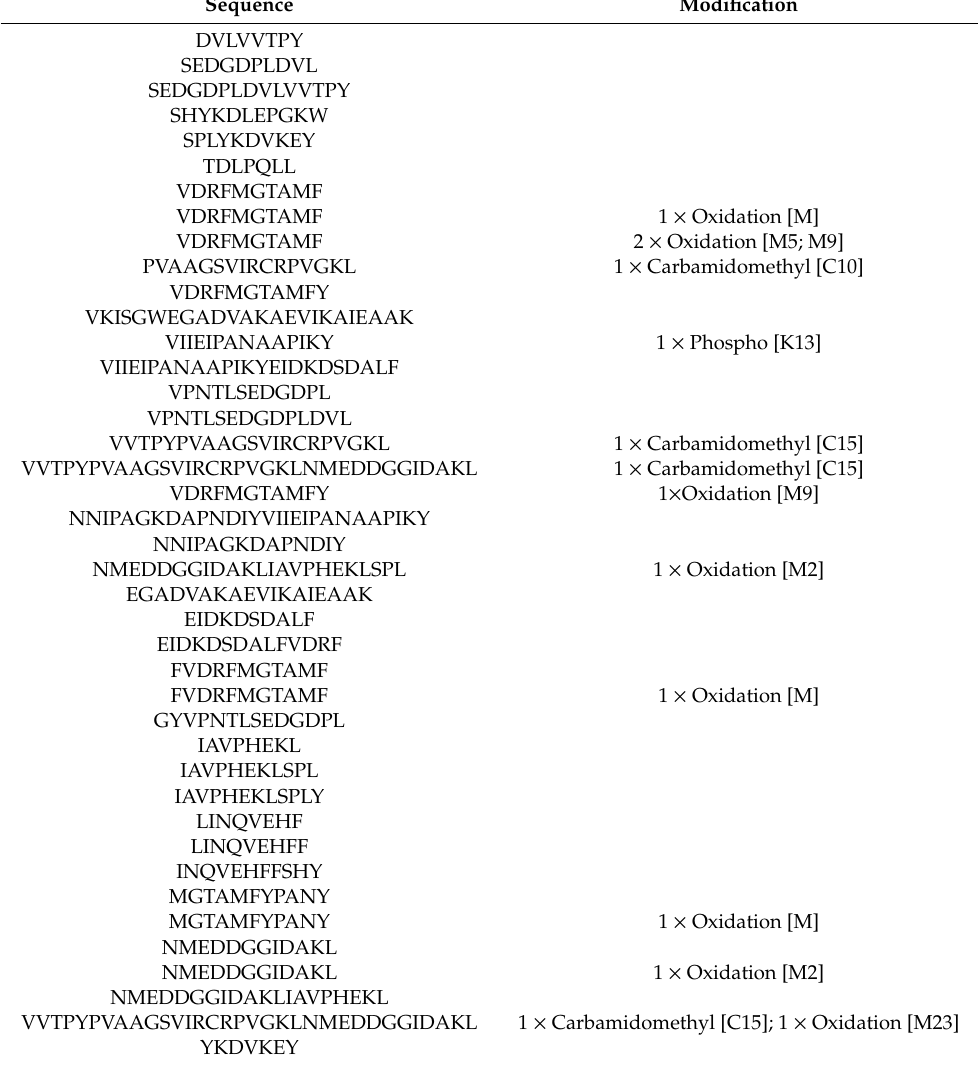
Figure 9. Mass spectrometry analysis of recombinant AbPPase after the in vitro PPi hydrolysis reaction to determine phosphorylation sites. A sufficient number of complementary Bn anions (N terminus-derived fragment ions) and Yn ions (C terminus-derived fragment ions) were detected to assign the phosphorylation sites to particular amino acids. Table 2. Peptides detected by mass spectroscopy.